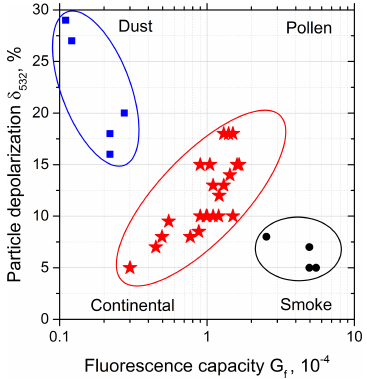
Figure 14. Particle depolarization δ 532 versus fluorescence capacity G F . This diagram allows for the identification of dust (blue), smoke particles (black) and aerosol mixtures containing pollen